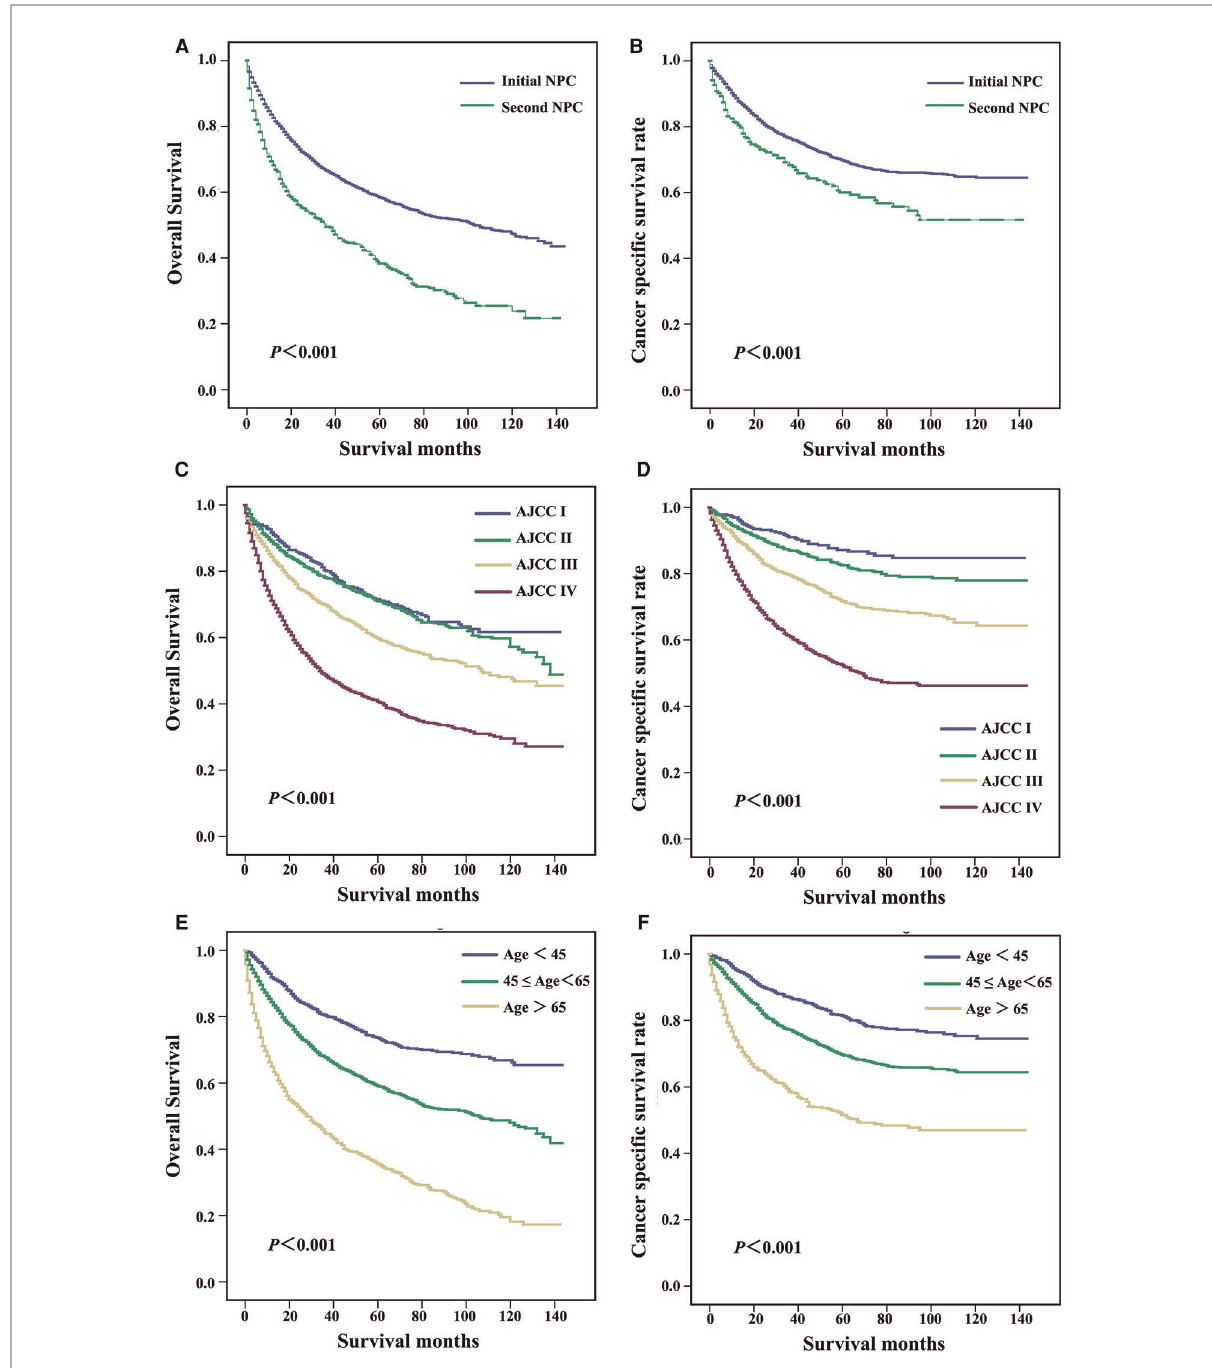
FIGURE 2 Survival curves for patients with different primary sites ( A,B ), AJCC stage ( C,D ), and age at diagnosis ( E,F